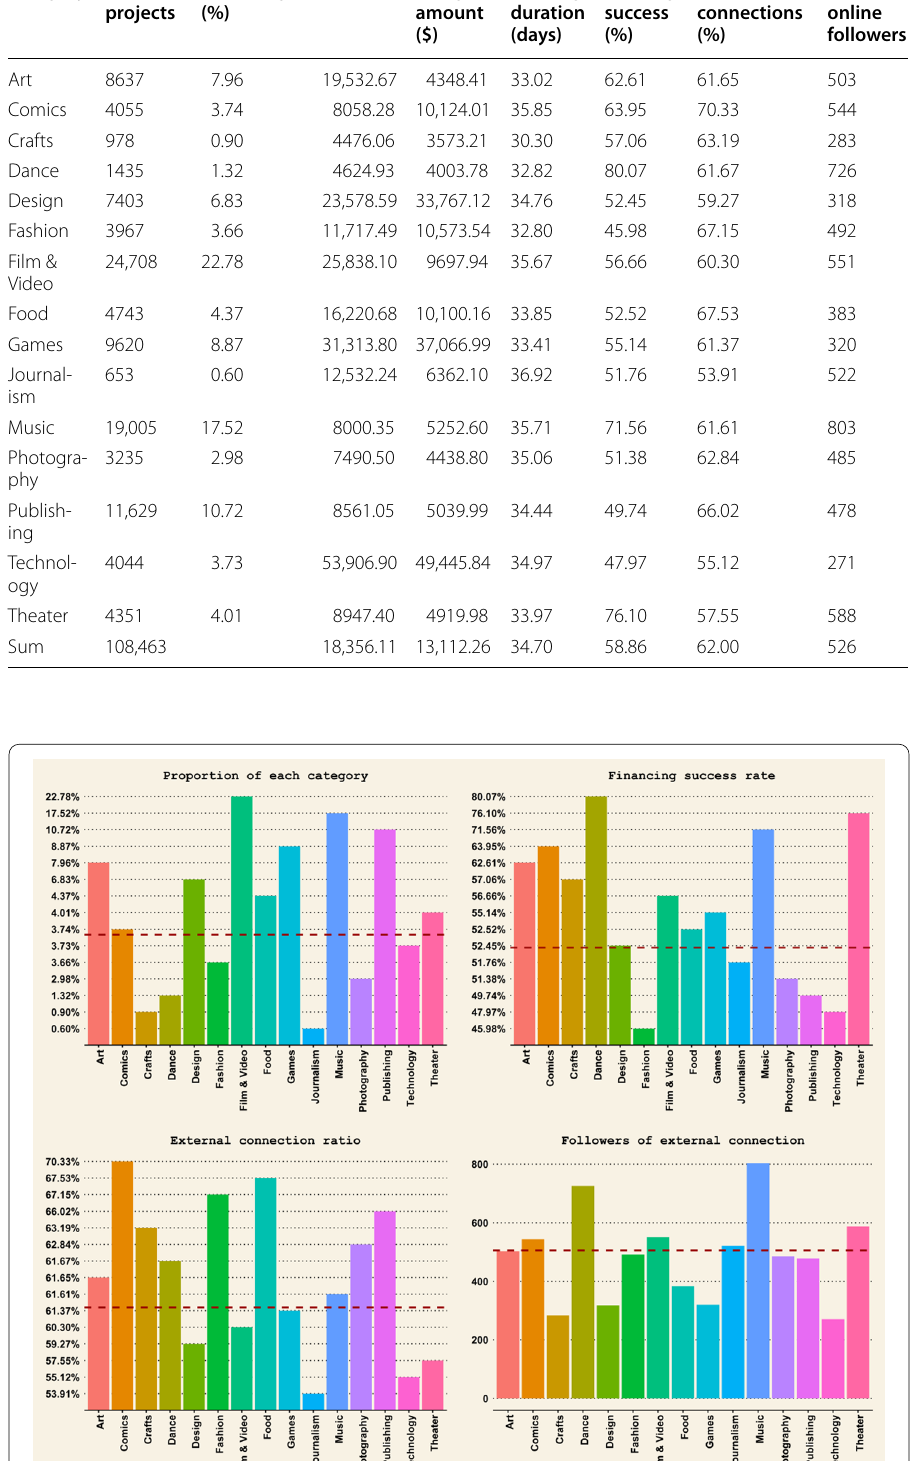
Table 1 Sample statistics of crowdfunding project categories on Kickstarter Category No. of projects